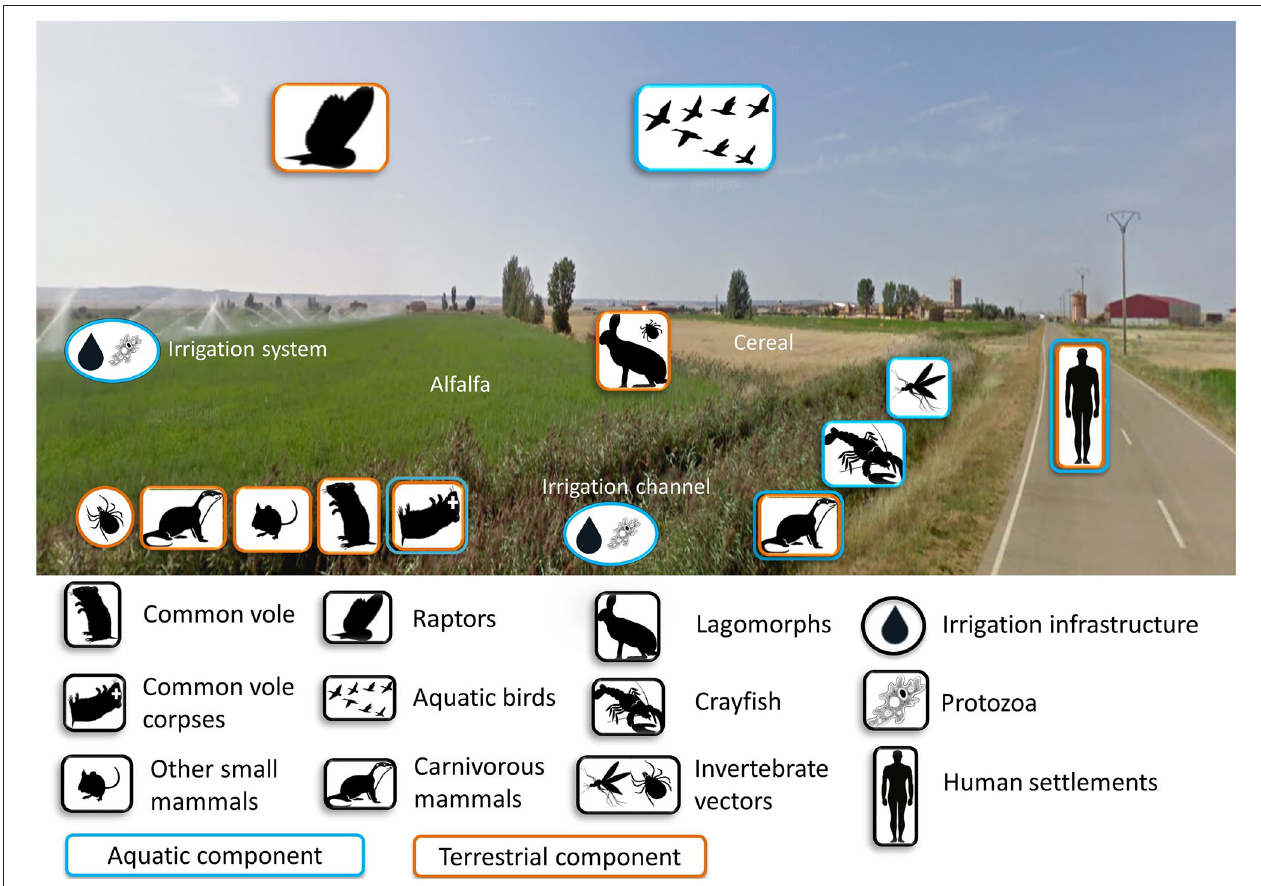
FIGURE 4 | Components potentially involved in the cycle of tularemia either as amplifying, maintenance, spillover or dead-end hosts in intensive farming landscapes of NW Spain. Photo by